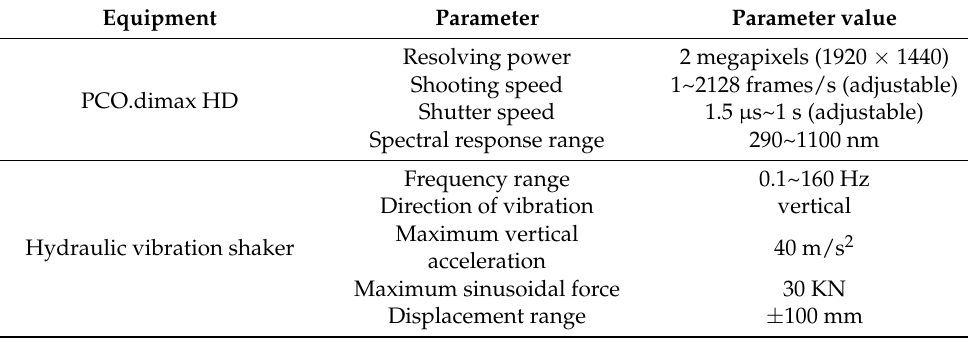
Table 1. Parameters of equipment used in the noncontact measurement method.